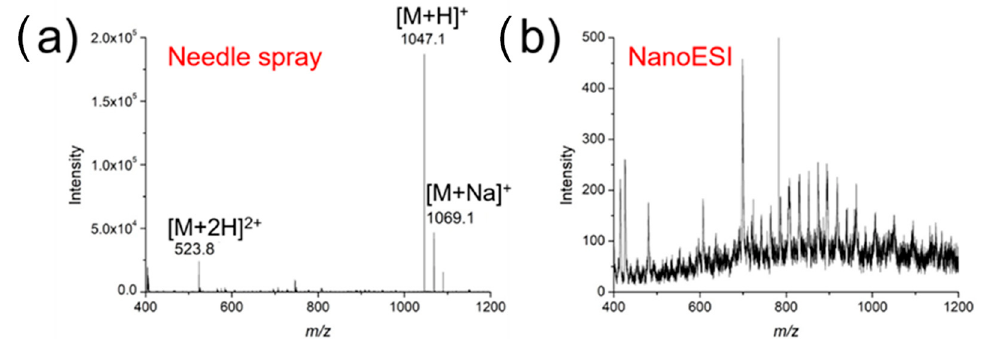
Figure 5. Mass spectra of angiotensin II (10 µ M, with 1% NaCl) ( a ) using a surface-coated needle for nanoESI and ( b ) conventional nanoESI in the positive ion mode.